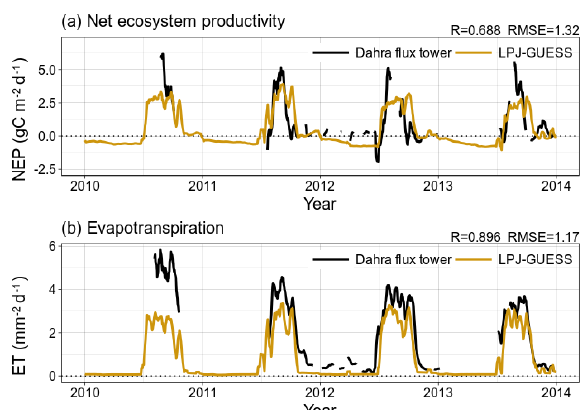
Figure 5. Time series of a 10d moving average of (a) daily net ecosystem productivity (NEP) and (b) daily evapotranspira- tion (ET), comparing measurements from the flux tower near Dahra, Senegal, with model results from LPJ-GUESS, using the Sahel-specific parameterization and WFDEI–MSWEP meteorolog- ical